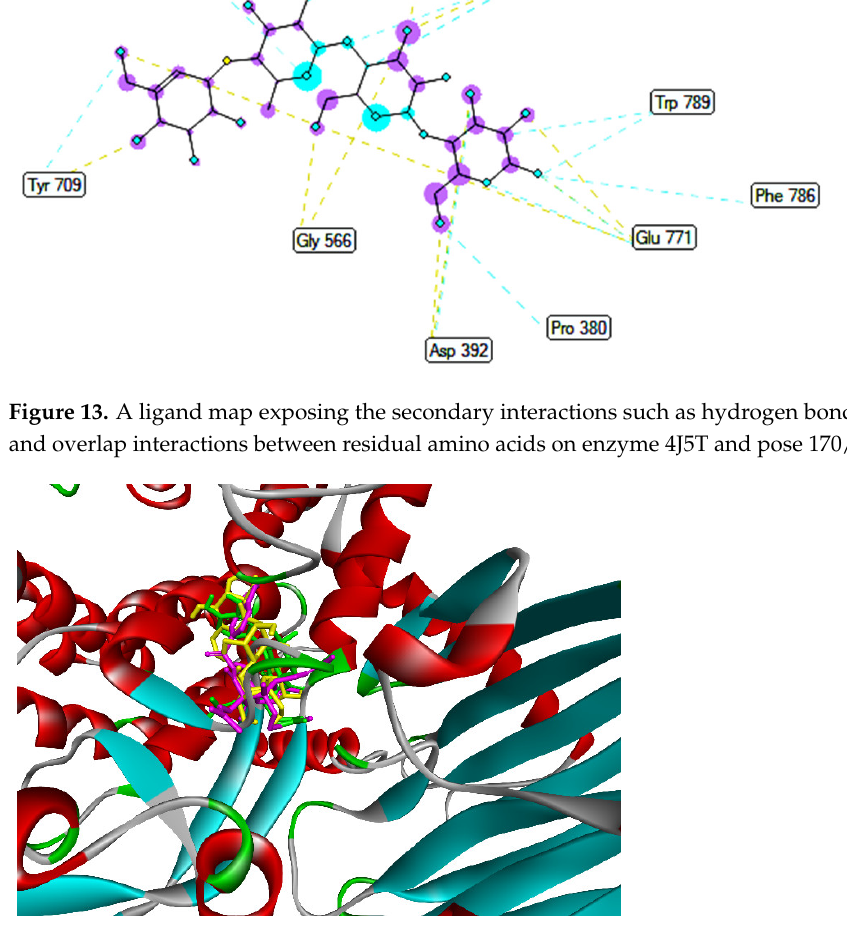
Figure 14. The best docking poses of ligands, pose 148 (green), pose 41 (violet), and pose 170 (yellow), docked to the same active center on enzyme 4J5T.